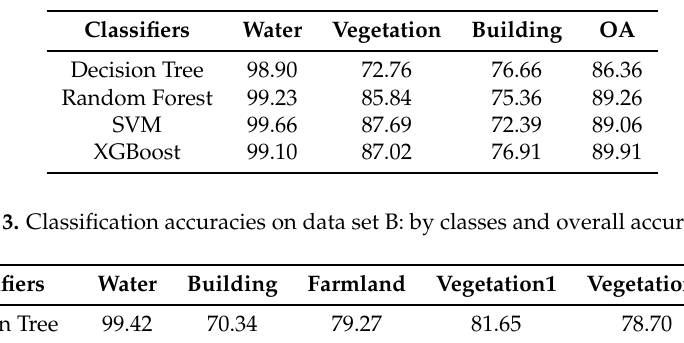
Table 2. Classification accuracies on data set A: by classes and overall accuracy (%).